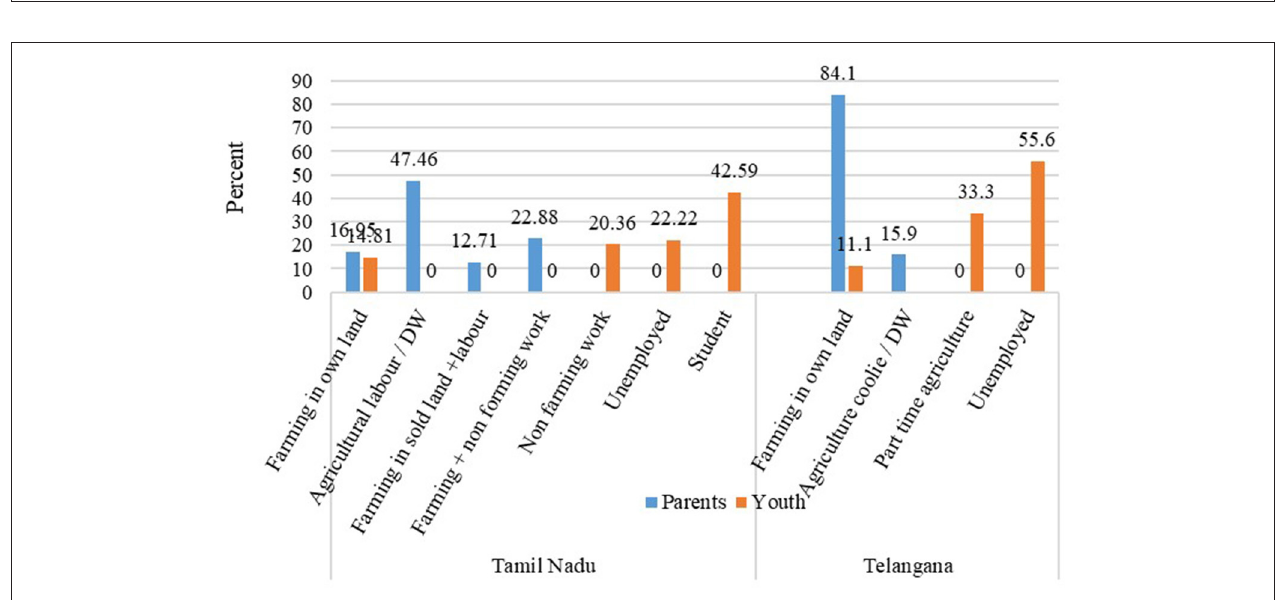
FIGURE 6 | Education of youth by gender in Telangana and Tamil Nadu sites.